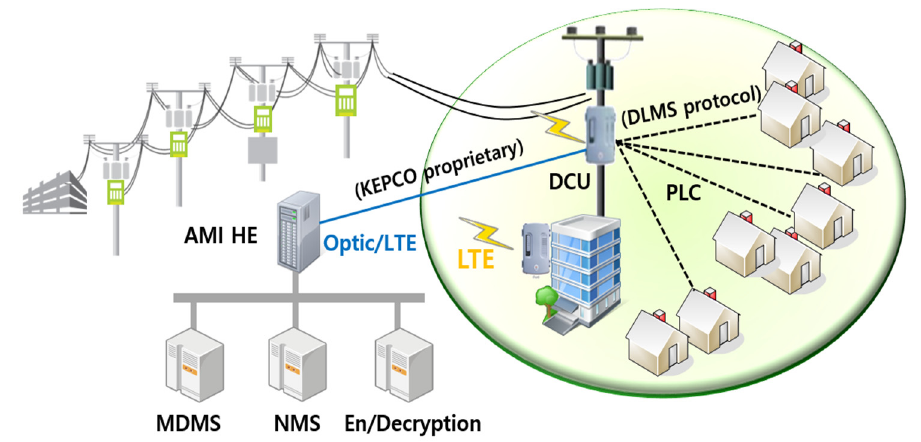
Figure 1. KEPCO AMI